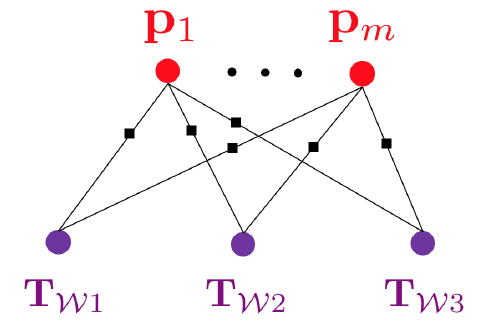
Figure 1. Factor graph of a classical visual Simultaneous Localisation And Mapping (SLAM) problem in which multiple views observe multiple 3D